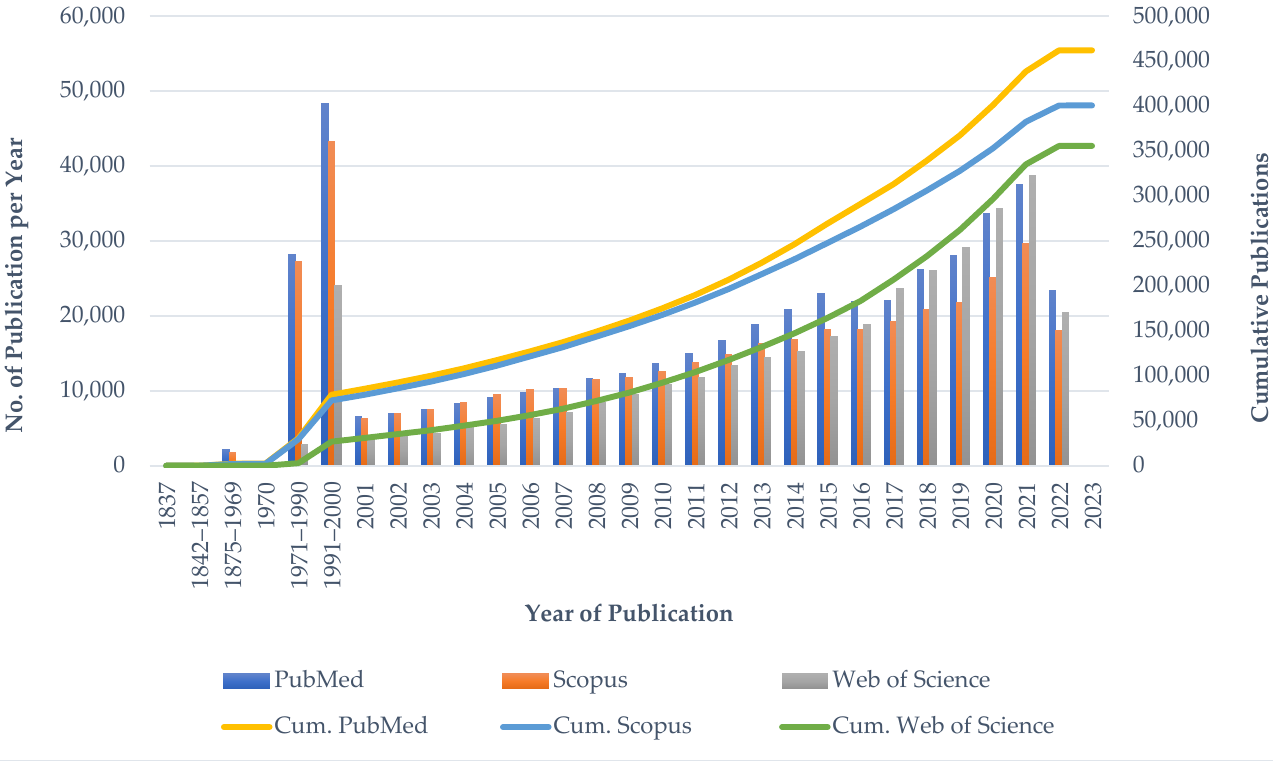
Figure 2. Growth Trend of Journal Publications on EoLC from three databases.